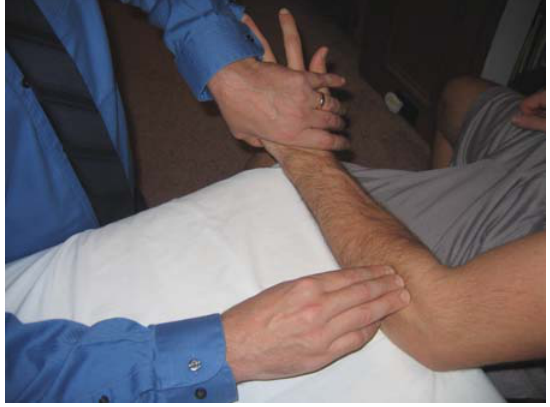
FIGURE 3. Example of transverse friction massage to wrist